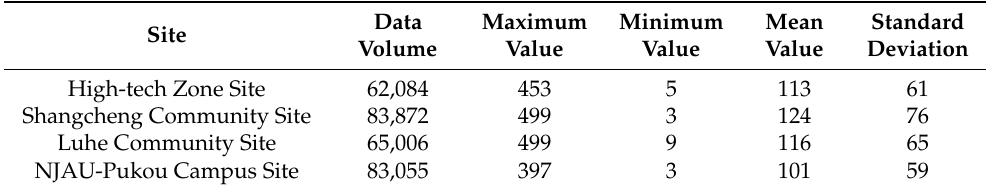
Table 2. Statistical analysis results of PM 2.5 concentration data.